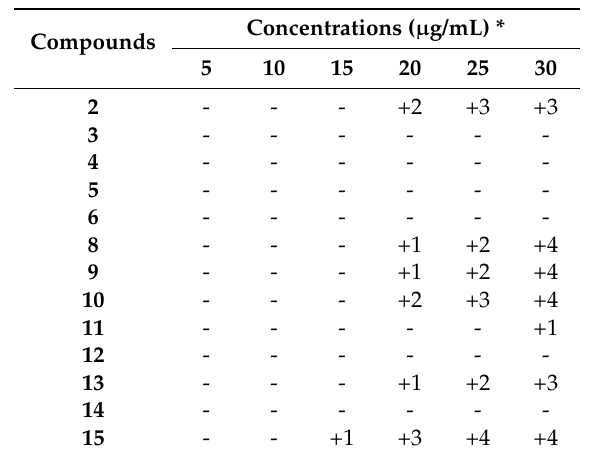
Table 1. Safe doses of each compound.